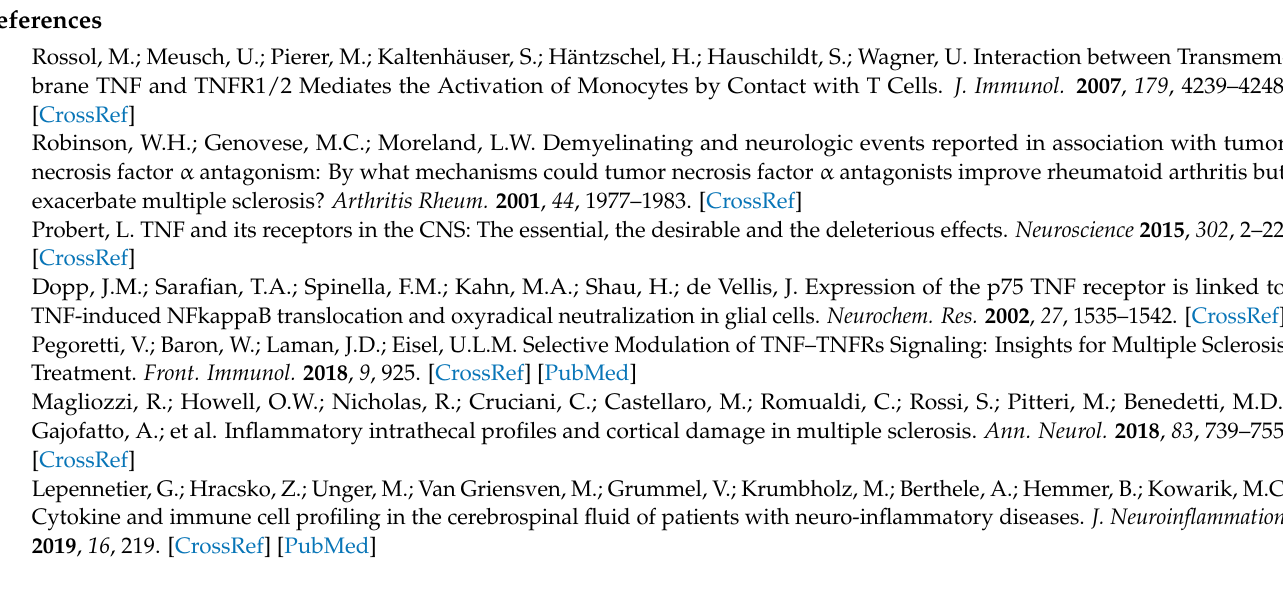
Table S4: IPA Disease and Functions categories related to CSF profile of MS-High patients compared to MS-Low patients; Table S5: Functional annotations encompassed Inflammatory Response category of MS-High patients’ CSF profile; Table S6: Functional annotations encompassed Lymphoid Tissue Structure and Development category of MS-High patients’ CSF